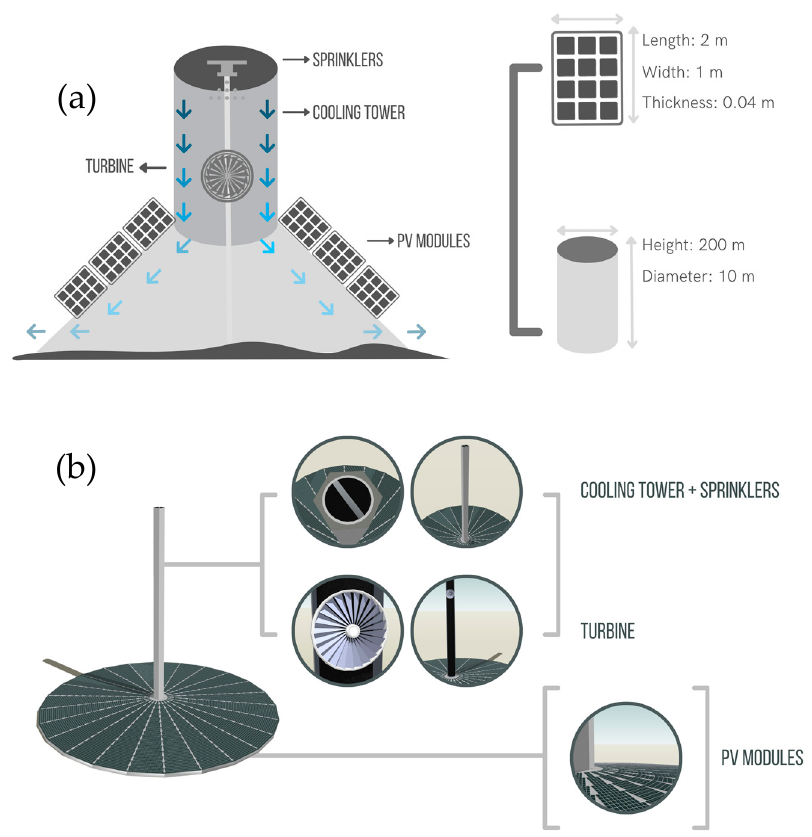
Figure 1. Proposed PV integration with the CT showing ( a ) the structure and physical dimensions of the system and ( b ) a 3D view of the system with PV panel arrangement.